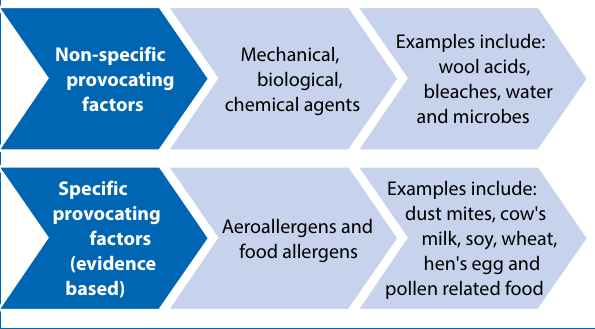
Figure 8: Different factors causing AD flare-ups